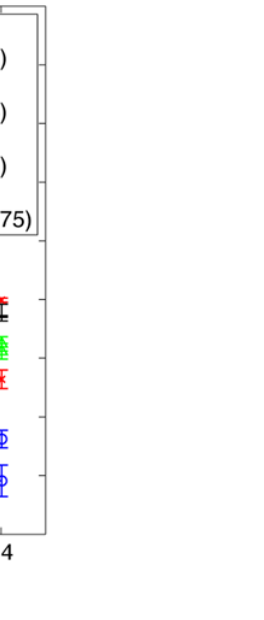
Figure 6. This plot shows that the effect of matrix degradation on average sprout extension speeds depends on the density of the ECM. Solid lines represent average extension speeds without matrix degradation and the corresponding colored dashed lines show average speeds with tip cell matrix degradation. For r ƒ 0 : 25 , matrix degradation has anti-angiogenic effects. Above r ~ 0 : 4 , degradation facilitates sprout